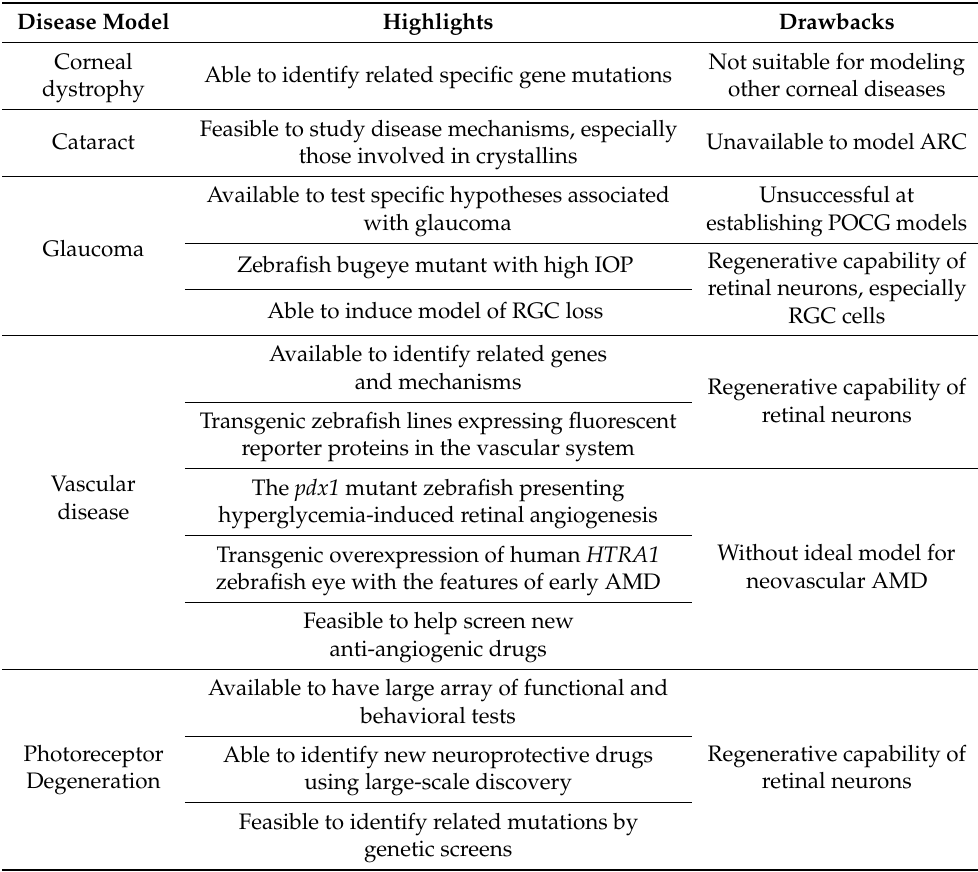
Table 4. Highlights and drawbacks of zebrafish models for common ocular